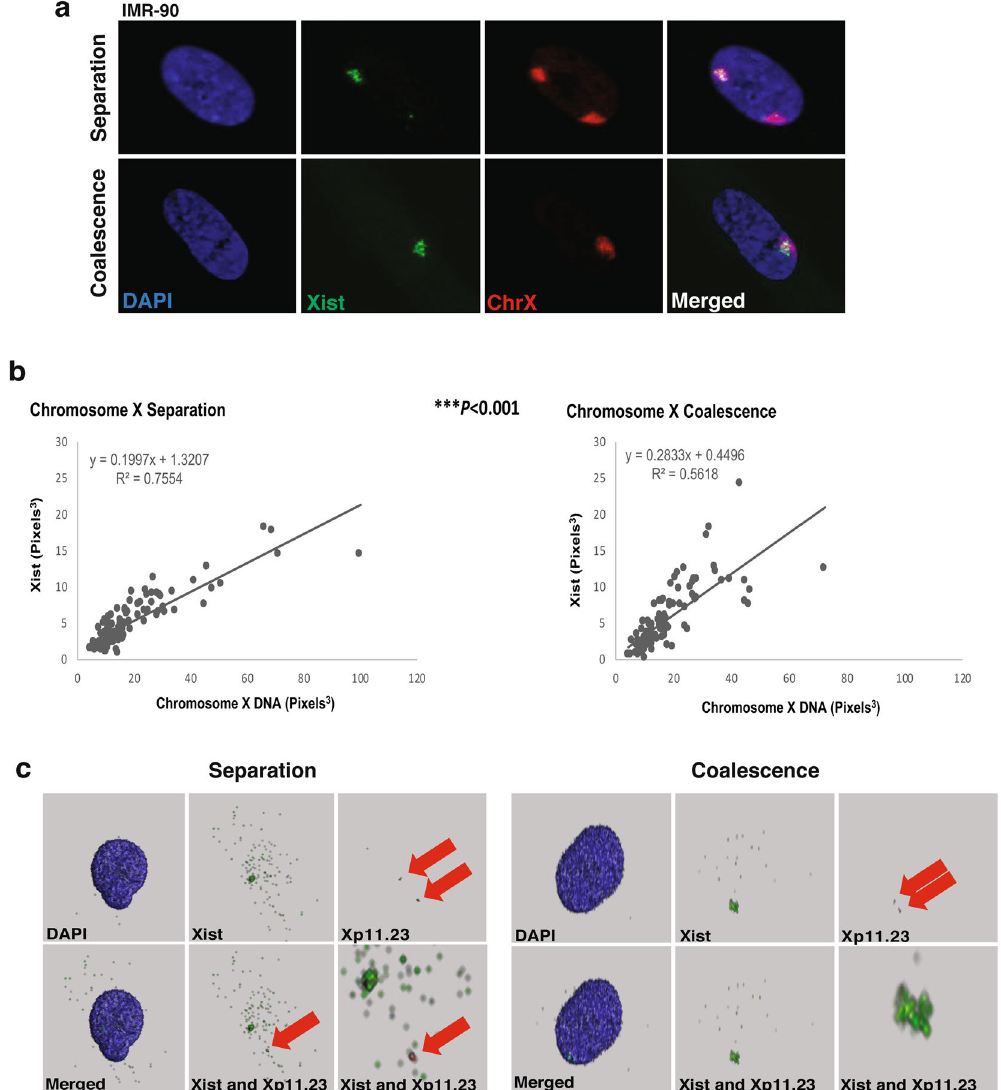
Figure 2. Xist coverage of chromosome X changes, during X coalescence in human female cells. ( a ) 3D maximum intensity projections of human IMR-90 nuclei (blue) with Xist (green) and chromosome X (red) labeled during X separation (upper panel) and coalescence (lower panel). ( b ) 3D volumetric measurements of Xist and total chromosome X, each data point represents measurements from one nucleus. A total of 100 nuclei analyzed during X separation and coalescence. * P < 0.05, ** P < 0.01, *** P < 0.001, linear regression t -test. ( c ) 3D renderings of IMR-90 nuclei (blue) with Xist (green) and Xp11.23 loci (red) labeled during chromosome X separation (left panels) and chromosome X coalescence (right panels). Red arrows highlight visible Xp11.23